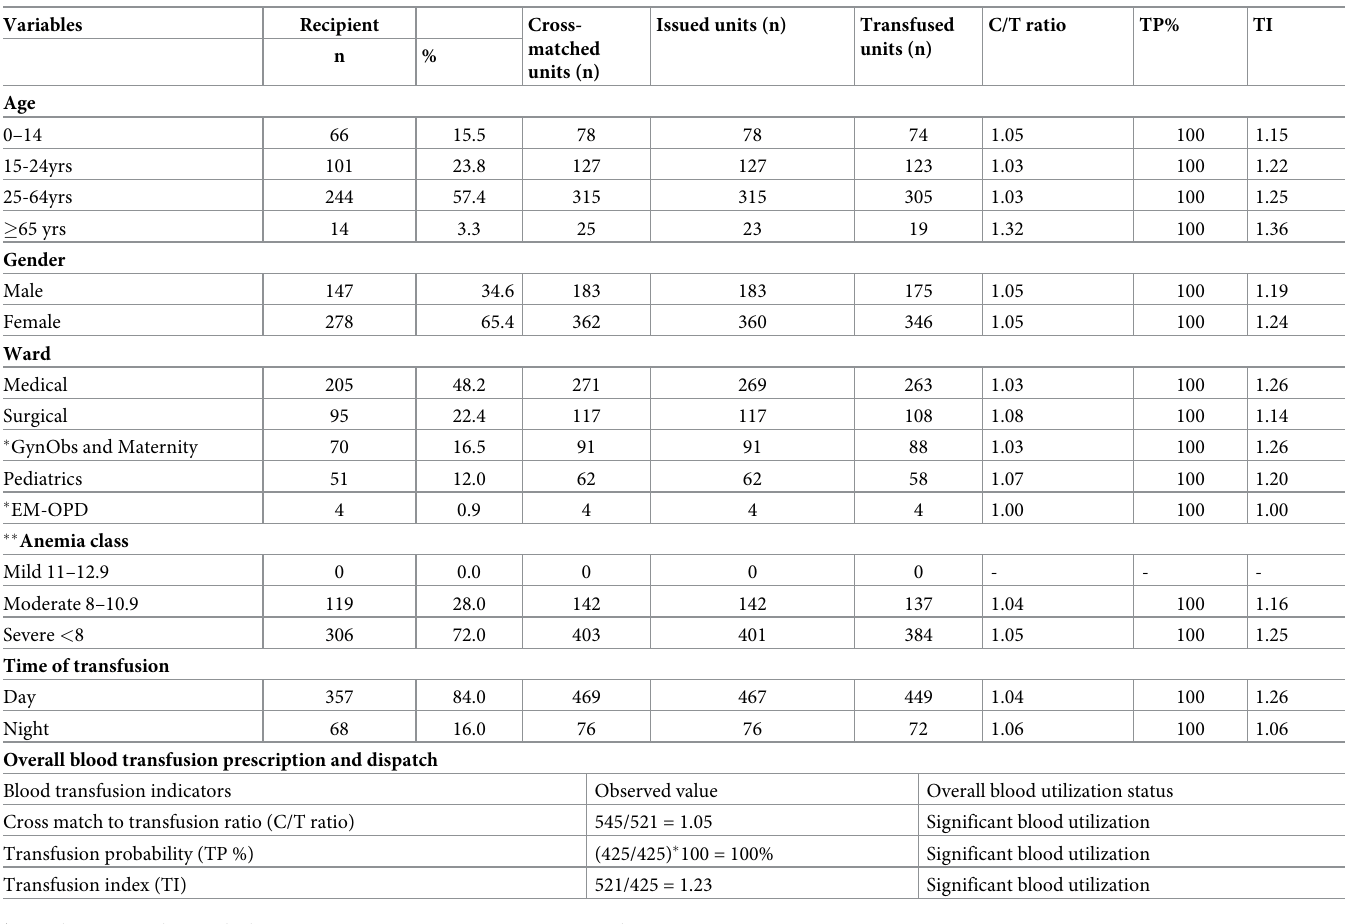
Table 6. Blood transfusion prescription and dispatch distribution to clinical variables at JMC, southwest Ethiopia, February 1 to June 30, 2018 (n = 425).